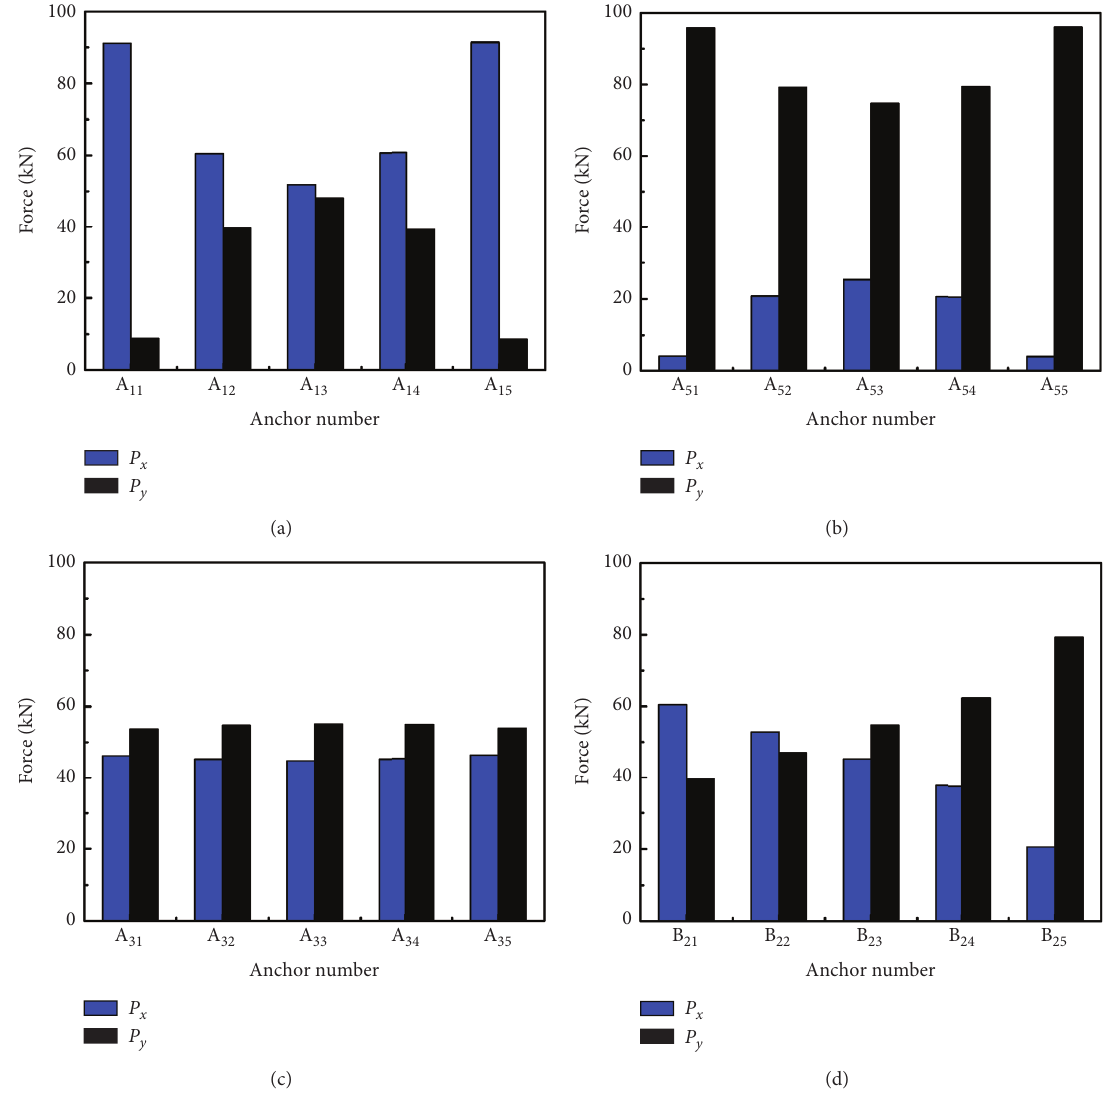
Figure 7: Distributed force. (a) The first row beam. (b) The fifth row beam. (c) The third row beam. (d) The second row